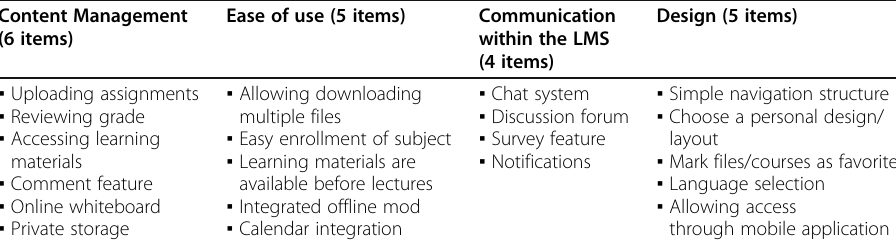
Table 3 The LMS design criteria from Laudon and Laudon (2018) Content Management (6